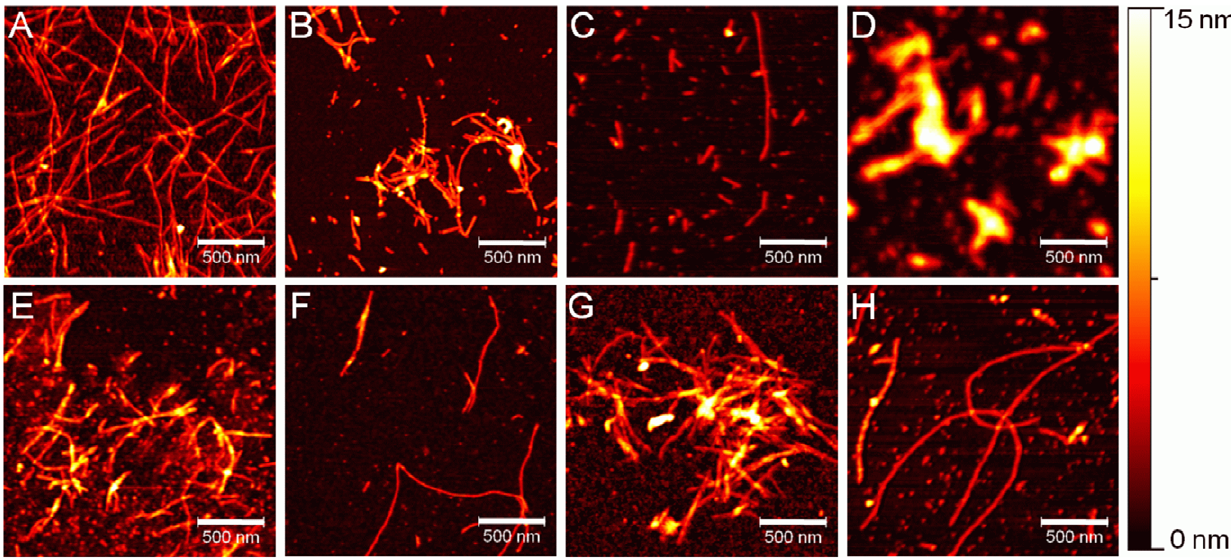
Figure 5. AFM analysis of a -syn aggregation in presence of test ligands as DOP analogs and alone. AFM height images were acquired from assay end products, which had been deposited onto freshly cleaved mica surfaces after 100 hours of incubation. All images are displayed using the same color scale as shown on the right hand side. (A–B) 5-hydroxyindole; (C) 4-(2-aminoethyl)aniline; (D-E) 6-aminoindole; (F) 2-amino-4-tert- butylphenol; (G) tyramine; (H) a -syn only.